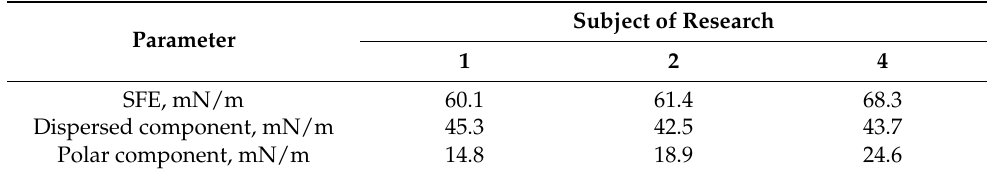
Figure 7. The results of measurements of the contact angle on the surface of the extracted initial sandstone and subjected to steam treatment. Table 8. Results of mathematical calculation of the free energy of the surface of the extracted initial sandstone and subjected to steam treatment.